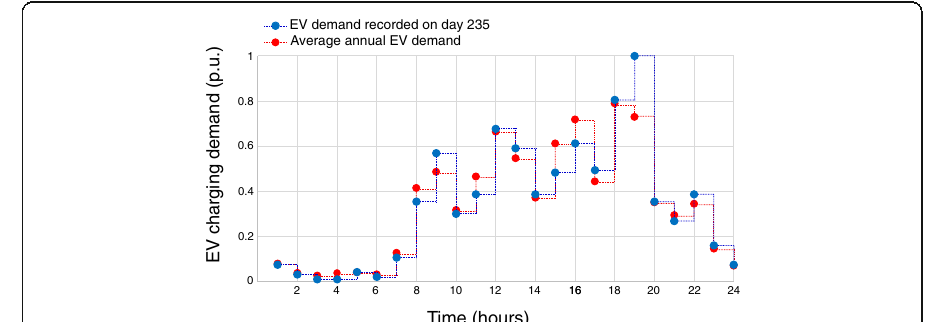
Fig. 1 EV charging demand